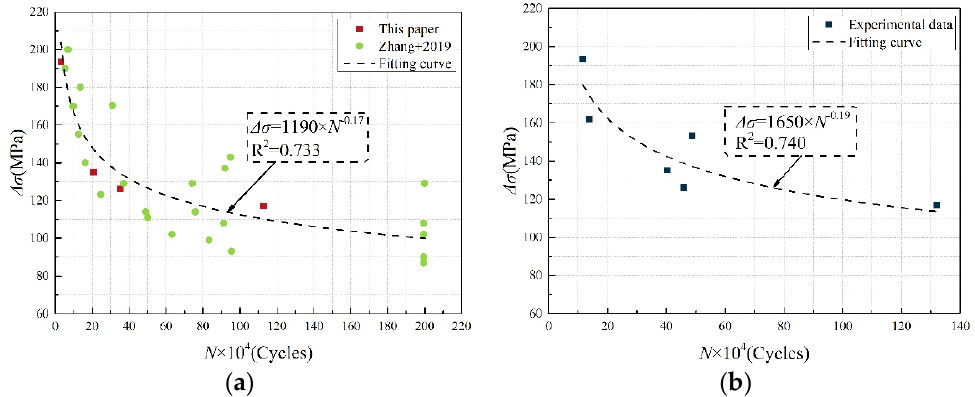
Figure 14. Power S-N curve fitting with ∆ σ as variable. ( a ) Unreinforced specimen ( b ) Strengthened with CFRP.